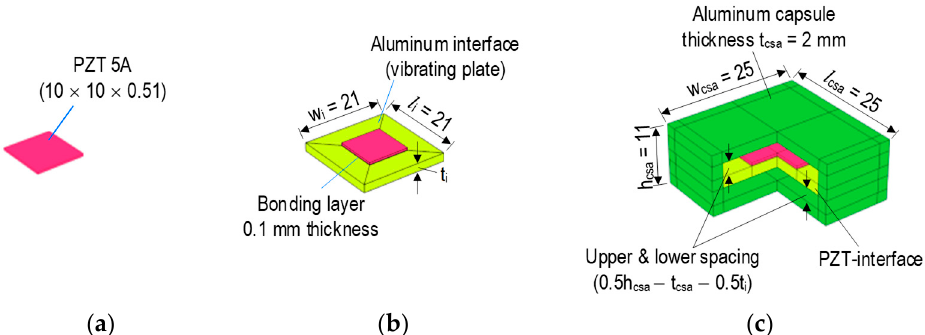
Figure 4. Prototype design of PZT-embedded capsule-like smart aggregate (dimension in mm). ( a ) PZT patch. ( b ) PZT interface. ( c ) CSA.